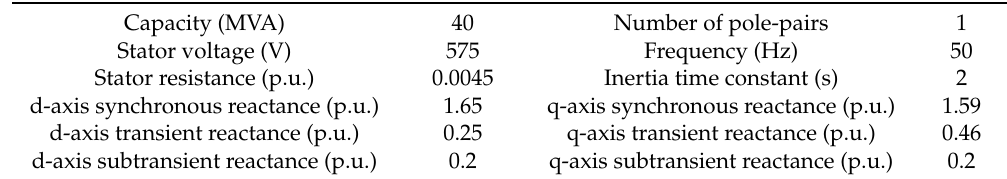
Table 3. Parameters of the synchronous